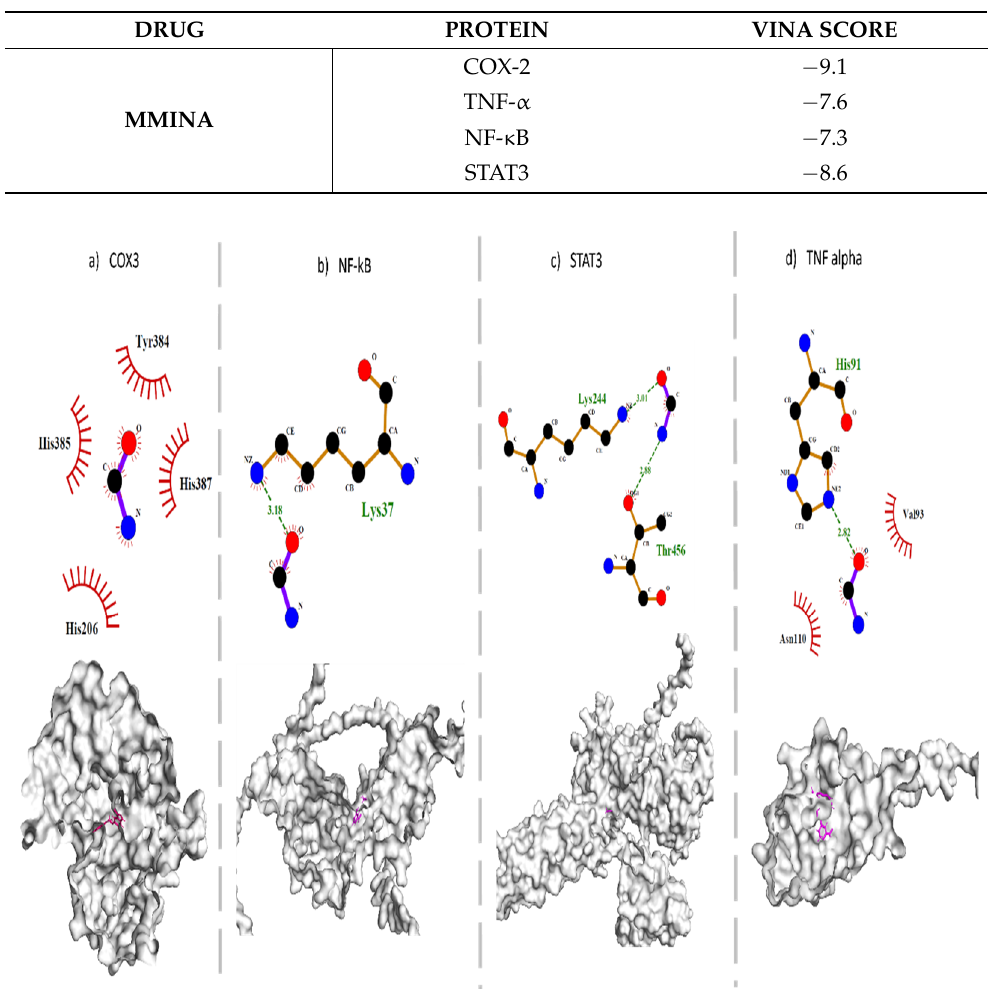
Figure 6. Molecular interactions between MMINA and pro-inflammatory proteins TNF-alpha, STAT3, COX-2, and NF-κβ . ( a ) The MMINA-COX2 complex has predominant hydrophobic interactions, whereas ( b ) the MMINA-NF-κβ complex and ( c ) the MMINA-STAT3 complex has hydrogen bonding, and ( d ) the MMINA-TNFalpha complex has both hydrogen bonding and hydrophobic interactions. Semi-circles in red color depict hydrophobic interactions, green dotted lines show hydrogen bonding, and green numbers indicate the distance between hydrogen-bonded ligand and amino acid. Purple-lined structure denotes ligand, while orange line structures represent amino acids. The surface view of the protein and ligand complex is shown below the 2D figure. Ligand is indicated with purple color.